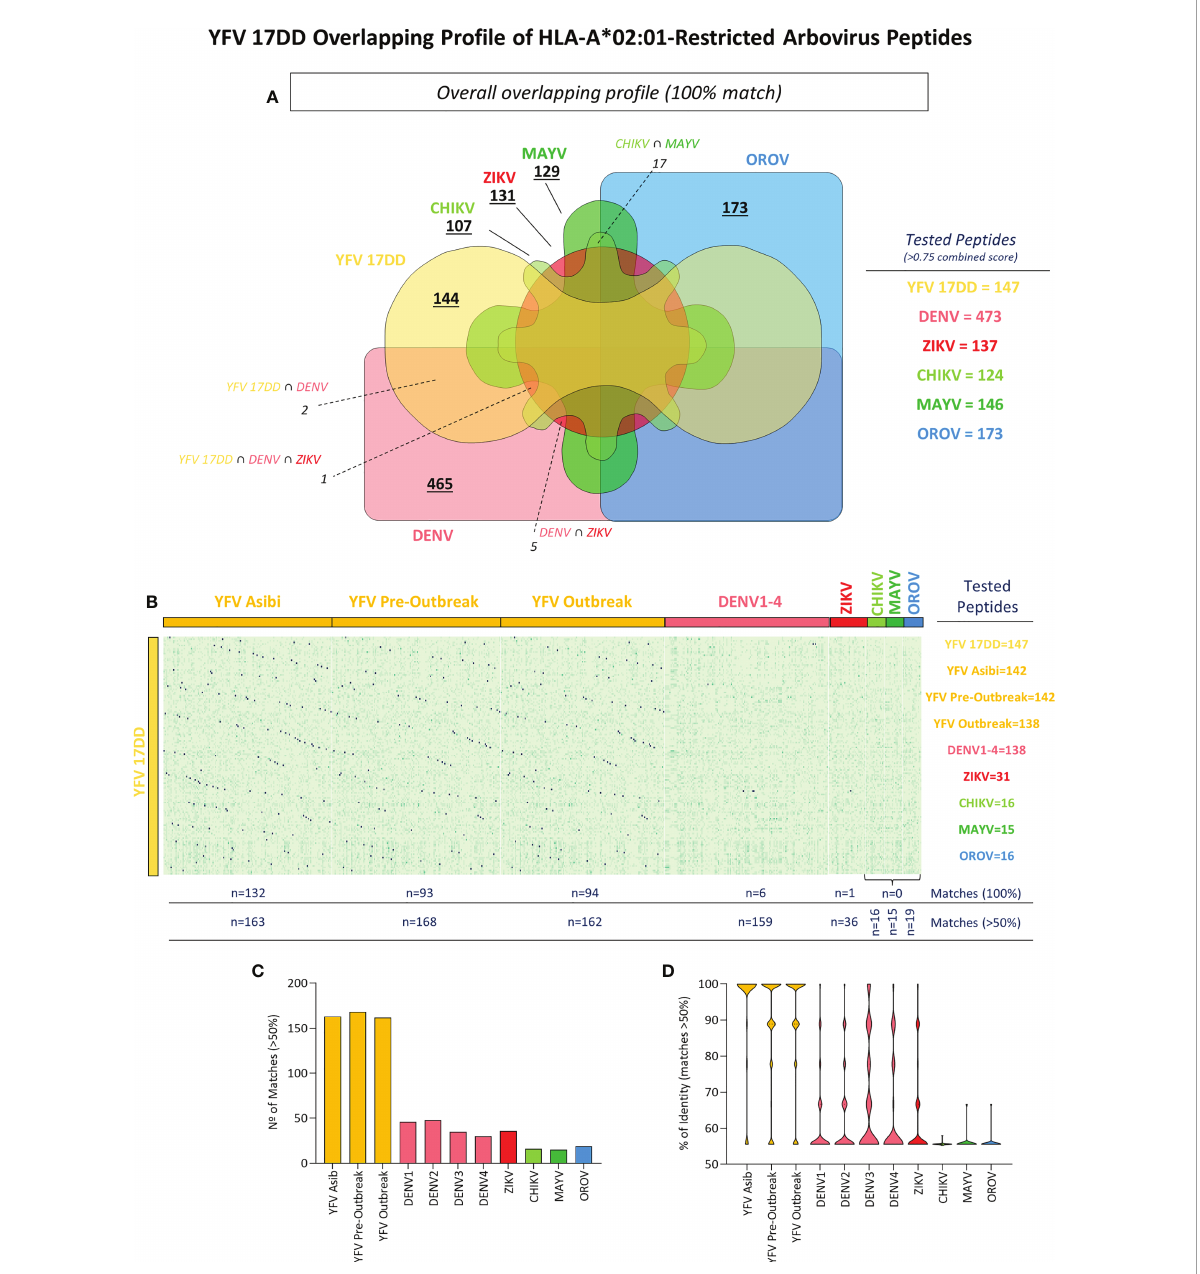
FIGURE 3 Identi fi cation of YFV-17DD Overlapping Peptides in Other Arboviruses and Assessment of HLA-A*02:01 Reactivity. (A) Venn diagram with shared peptides between all assessed arboviruses. Intersecting regions between arboviruses and YFV-17DD are indicated by dotted lines. (B) Heatmap analysis with percentage of identity between HLA-A*02:01-restricted peptides from arbovirus. Y axis indicated YFV-17DD peptides, X axis indicates peptides from other arboviruses. Only peptides with an identity rate ≥ 50% with peptides derived from YFV-17DD were considered (C) Number of matches with YFV-17DD peptides for all assessed arbovirus. (D) Violin plot with percentage of overlapping peptide ’ s identity from all assessed arboviruses with YFV-17DD